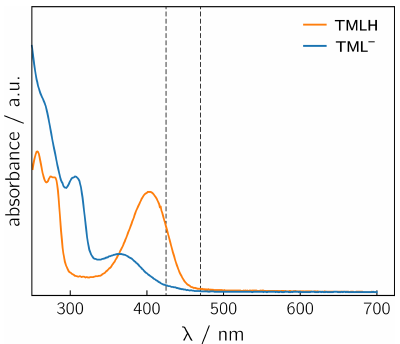
Figure 3. UV/vis spectra of TMLH and TML − recorded in water and in 1M NaOH, respectively. The vertical dashed lines indicate the wavelengths chosen for sample irradiation (425 and 470nm).